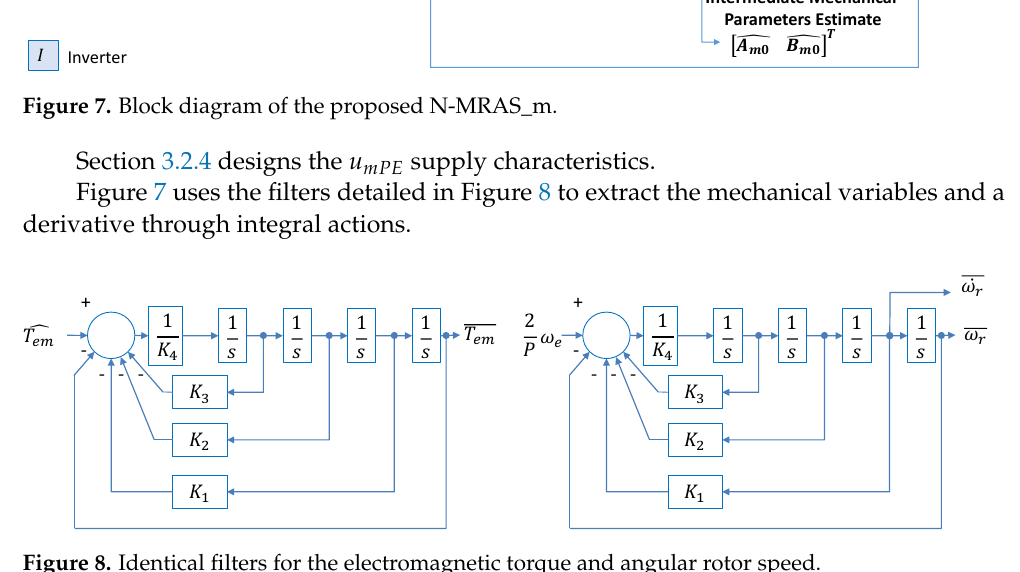
Figure 8. Identical filters for the electromagnetic torque and angular rotor speed.